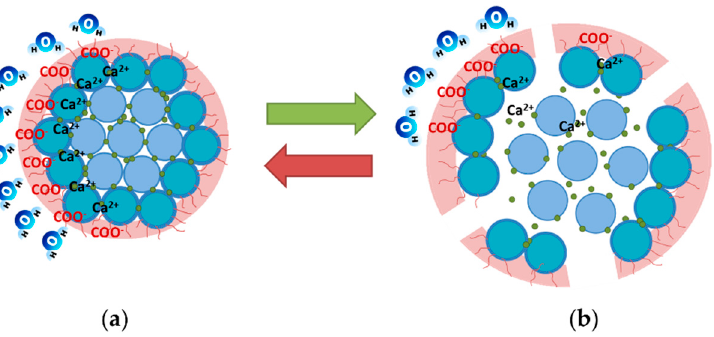
Figure 3. Schematic diagram of potential CM structure in native ( a ) and in disintegrated state ( b ).